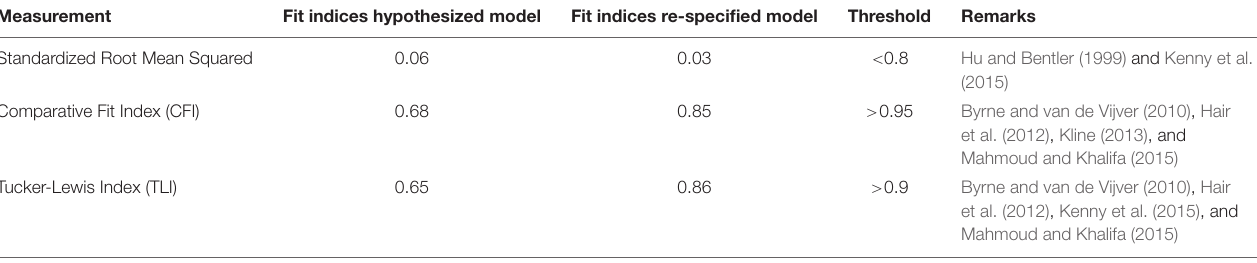
TABLE 9 | Goodness-of-fit.